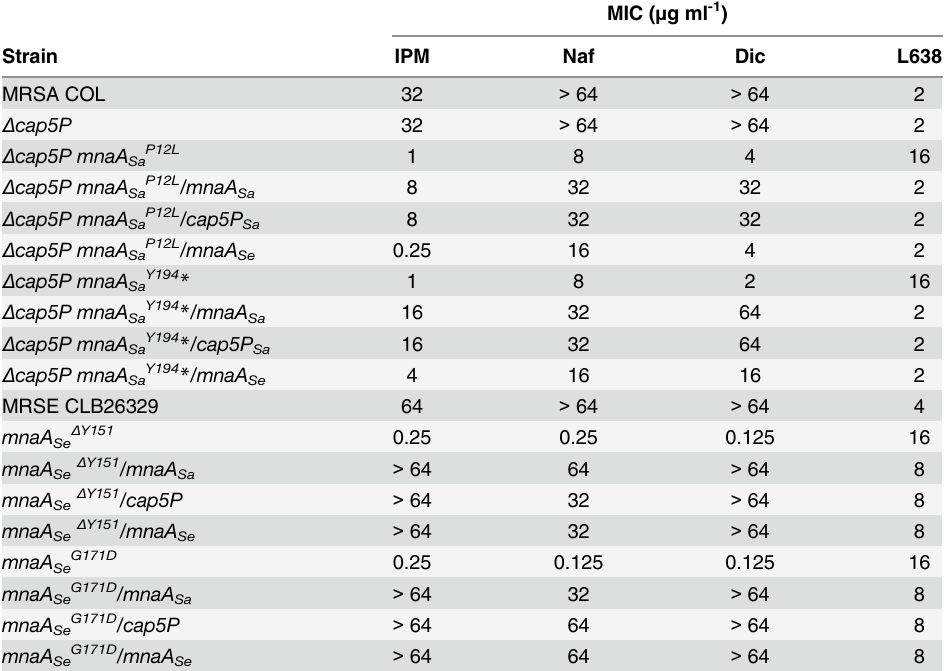
Table 1. Genetic inactivation of mnaA in methicillin-resistant Staphylococci restores β -lactam